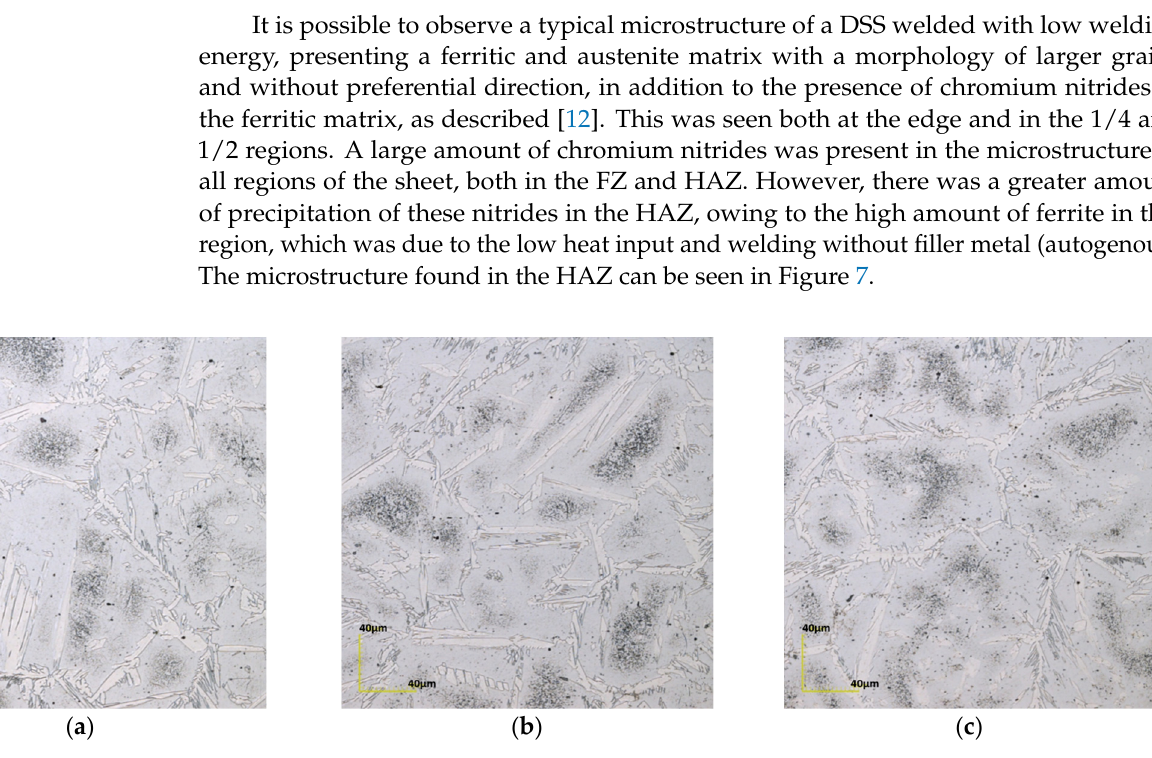
Figure 6. Microstructure observed in the FZ of the as-welded condition sample: ( a ) edge; ( b ) 1/4 region; ( c ) 1/2 region.